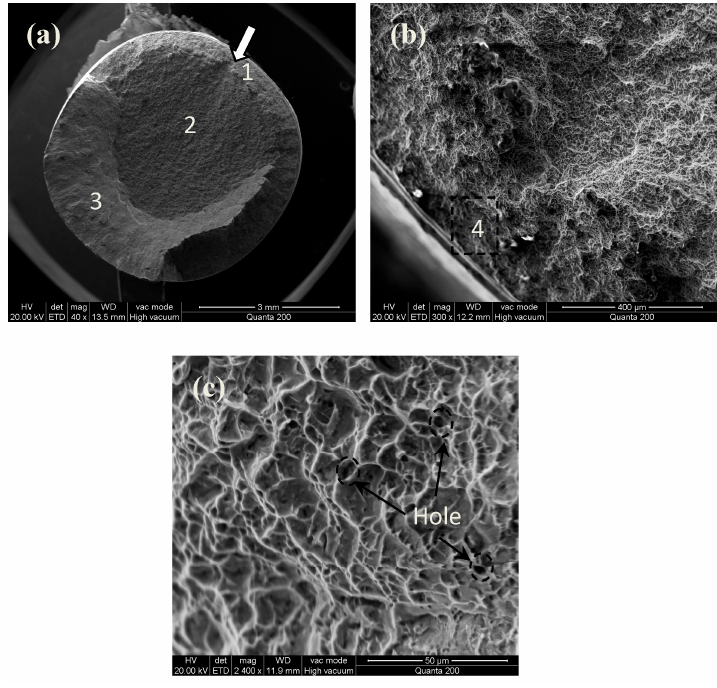
Figure 10. Tensile fracture morphologies of untreated specimen: ( a ) 40×; ( b ) the crack initial site; ( c ) the microstructure of area “4”.